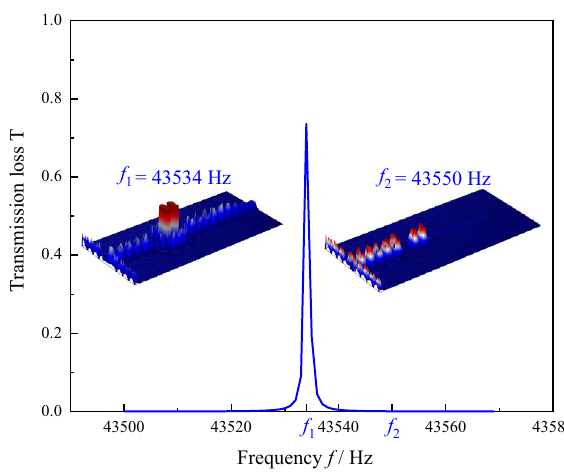
Figure 9. Sound field distribution in the sensor when sensing 10% solution concentration (These figures are made by COMSOL Multiphysics 6.1 25